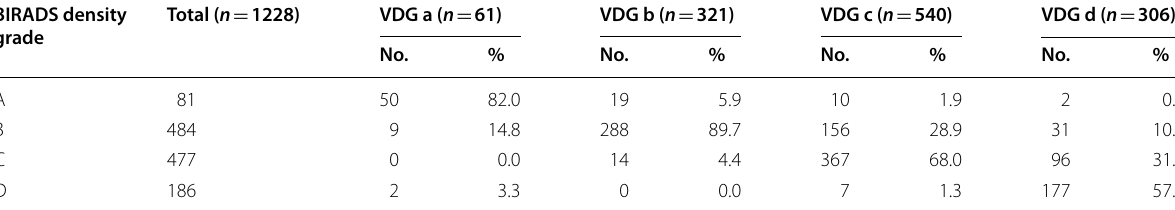
Table 3 Level of Agreement between VDG and ACR- BIRADS Grading